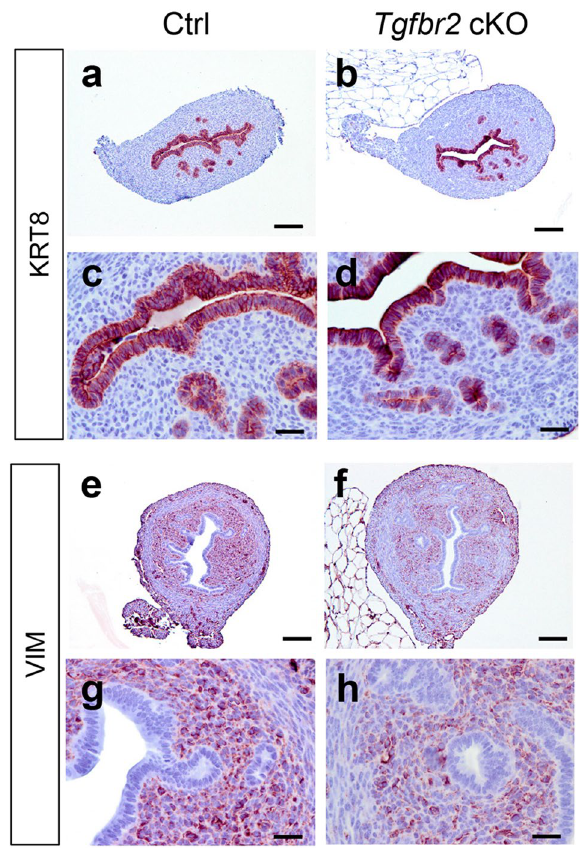
Figure 2. Normal specification of epithelial and stromal compartments in Tgfbr2 cKO during early postnatal development. ( a–h ) Immunostaining of KRT8 and VIM in the uteri of controls and Tgfbr2 cKO at PD15. ( c , d , g , h ) Are higher magnification images for ( a , b , e , f ), respectively. Three independent mice were examined for each genotype. Scale bar equals 25 µm ( c , d , g , h ) and 100 µm ( a , b , e , f